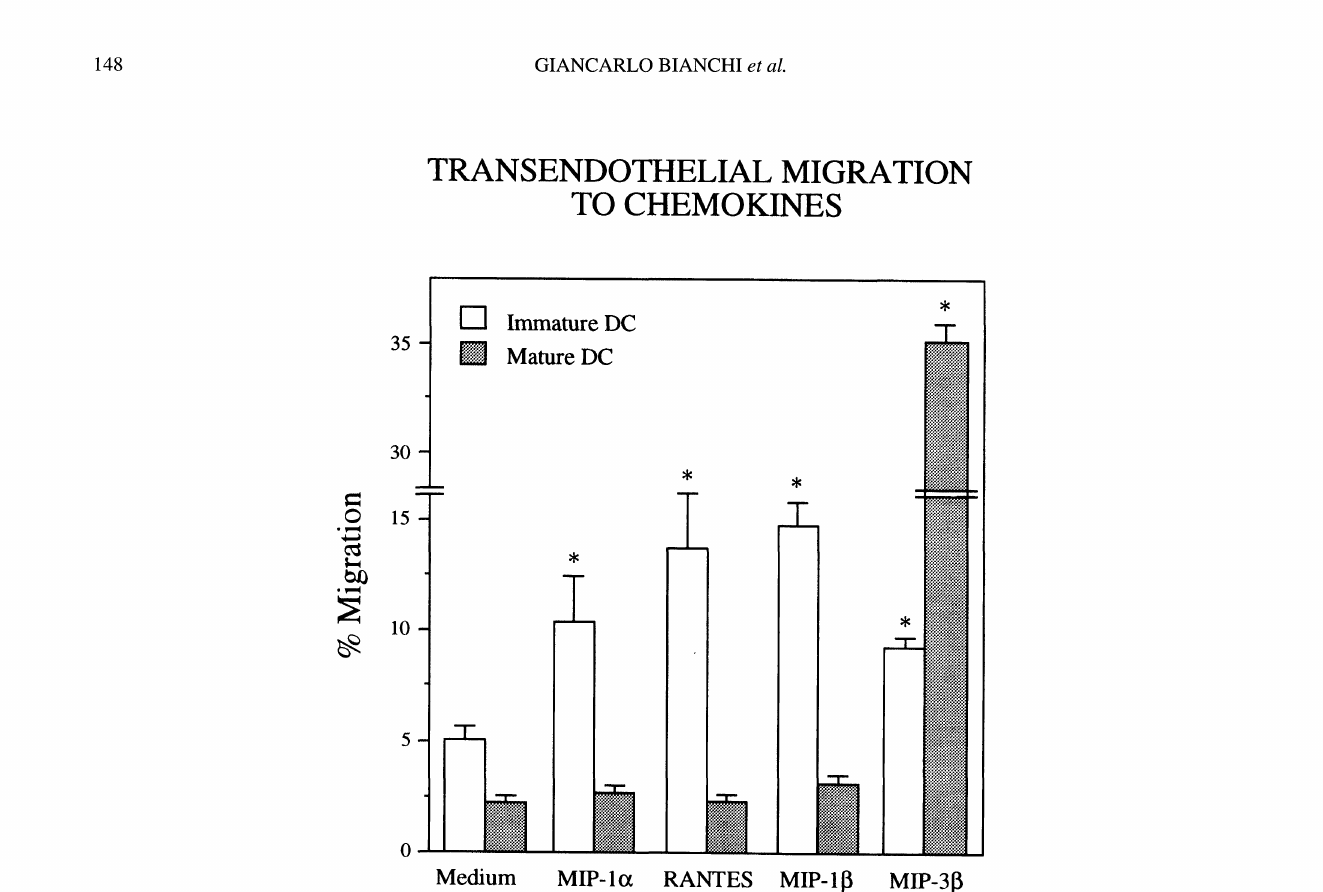
FIGURE 4 Effect of chemoines on transendothelial migration of immature and CD40L-matured DC. Policarbonate transwell inserts were coated with a monolayer of EC and chemoattractants (100ng/ml) were seeded in the lower compartment. 51-Cr labeled DC were placed in the upper compartment and incubated for lh at 37C. * Statistically significant at p<0.01